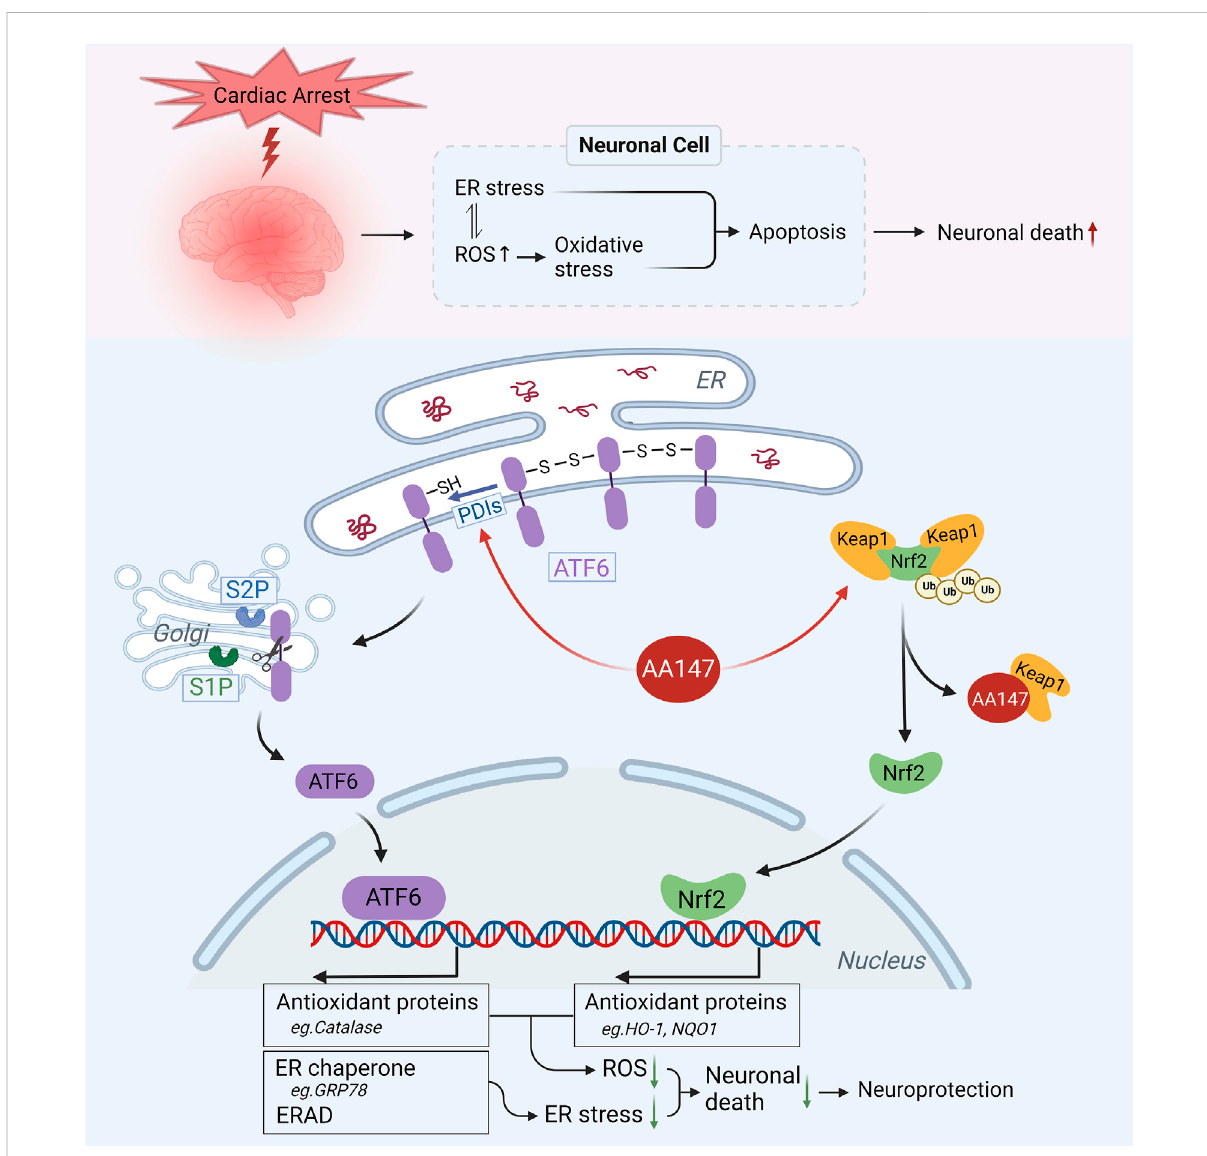
FIGURE 8 Proposed mechanism for the neuroprotective effect of AA147 against post-cardiac arrest (CA) cerebral ischemia/reperfusion injury (IRI). ER stress and oxidative stress induced by post-CA cerebral IRI results in numerous neuronal death. AA147 elevates ATF6 and Nrf2 levels in the neurons and increases their nuclear translocation by covalently modifying PDIs (restraining ATF6 within ER by regulating ATF6 disul fi de) and Keap1 (keeping Nrf2inlowlevelsoutsidethenucleusbypromotingitsubiquitination).AA147-inducedactivationofATF6couldupregulatetheexpressionofER chaperones (e.g., GRP78) and ER-associated protein degradation (ERAD) components to restore ER proteostasis, also activating several antioxidant genes,includingcatalase,toscavengeoverproducedROS.Atthesametime,Nrf2couldinducetheexpressionofHO-1,NQO1,andotherantioxidant proteins to inhibit oxidative stress. The AA147-induced synergistic effect of two signaling pathways reduces neuronal death caused by post-CA cerebral